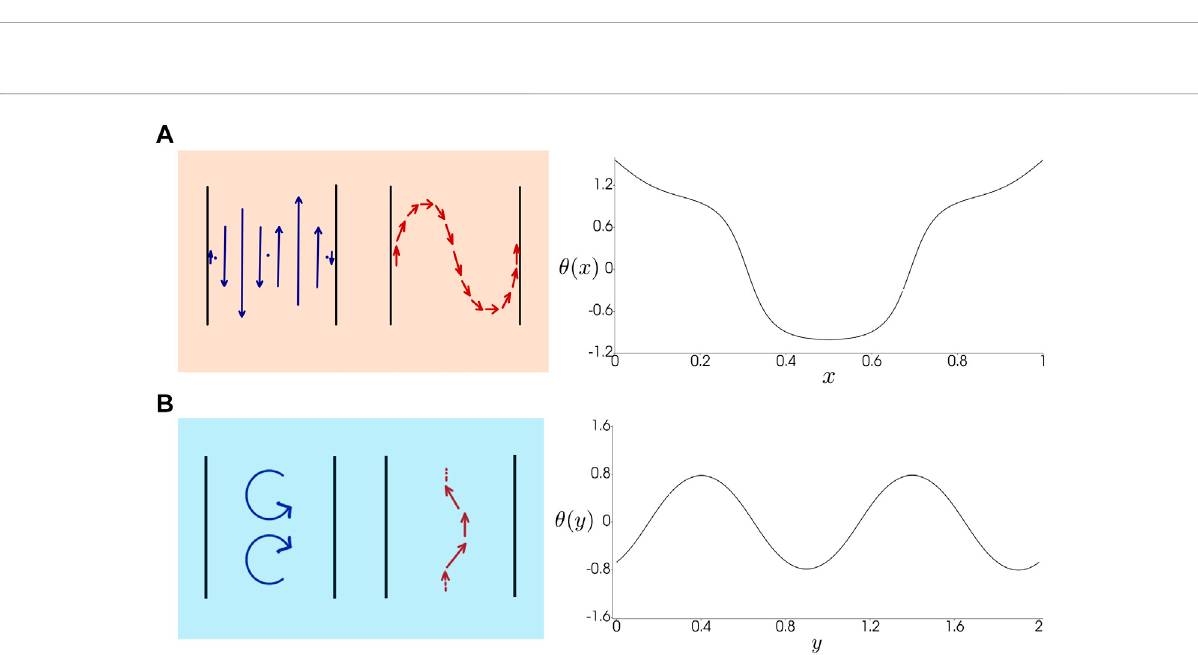
FIGURE 6 Schematic (L = W) for the shear banded and the vortex lattice fl ows. The line plot shows the angle θ along the polarization p for the two fl ow states from the numerical simulations (L = 2W) in the case of strong anchoring ( ℓ κ / W = 0.01, ℓ η / W = 0.30). (A) Shear Banded Flow (angular pro fi le is shown for α =-3.80). (B) Flow Vortex Lattice (angular pro fi le is shown for α